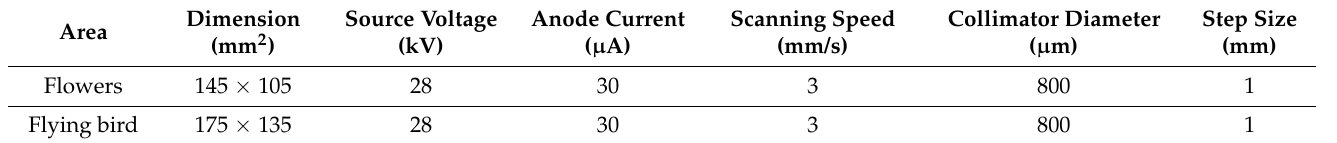
Table 1. Scanning parameters of the areas of the chinoiserie lacquered